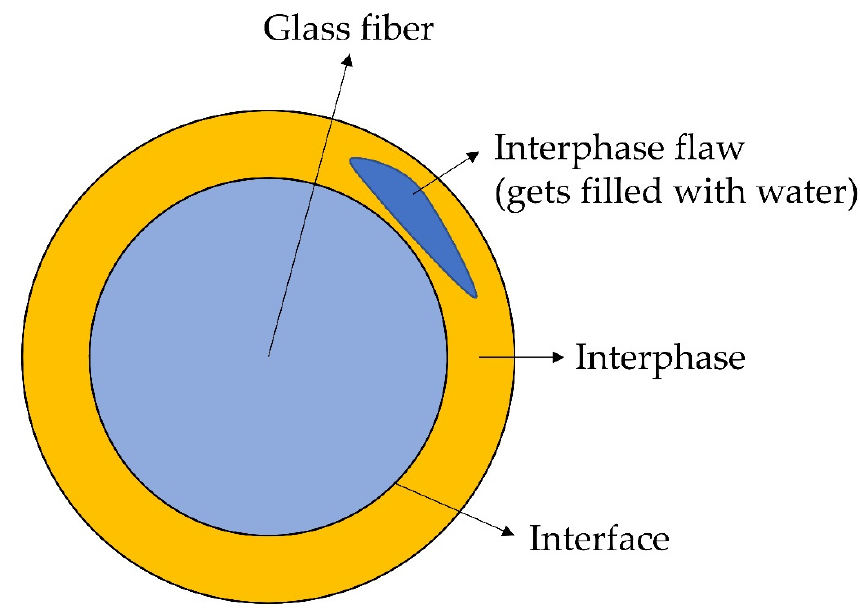
Figure 6. The interphase flaw is formed and gets filled with water, reproduced from [13].